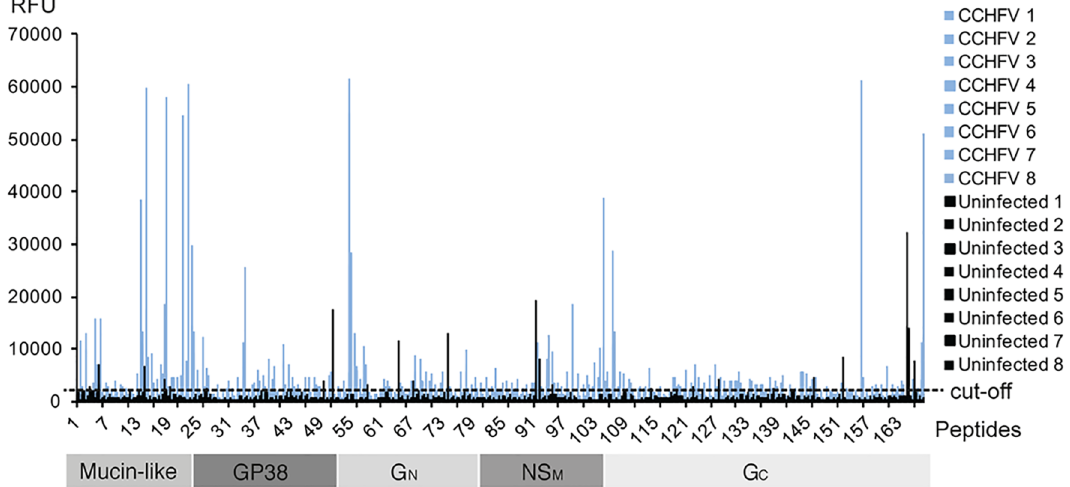
Fig 1. Reactivity of pooled Turkish sera. Reactivity of eight CCHFV survivor pools (blue) and six uninfected pools (black) against 168 peptides representing the complete precursor glycoprotein of CCHFV (Turkish strain, Kelkit06, Uniprot #C7F6X8).